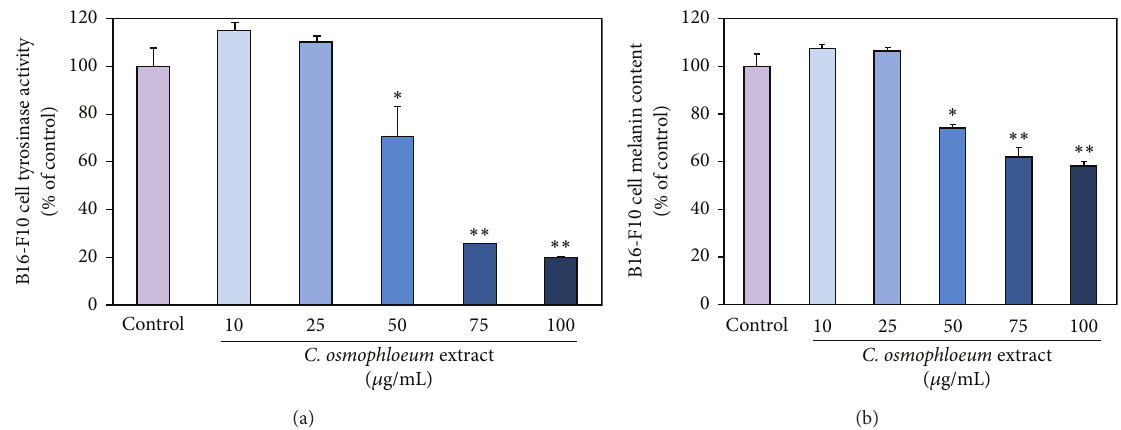
Figure 3: The inhibitory effects of various concentrations of C. osmophloeum extracts on B16-F10 cells. (a) The tyrosinase activity and (b) the melanin content of B16-F10 cells were incubated with indicated concentrations of C. osmophloeum extracts. Data: the mean value ± SD (triplicate values for three independent experiments); ∗ < 0.01 , ∗∗ < 0.001 .